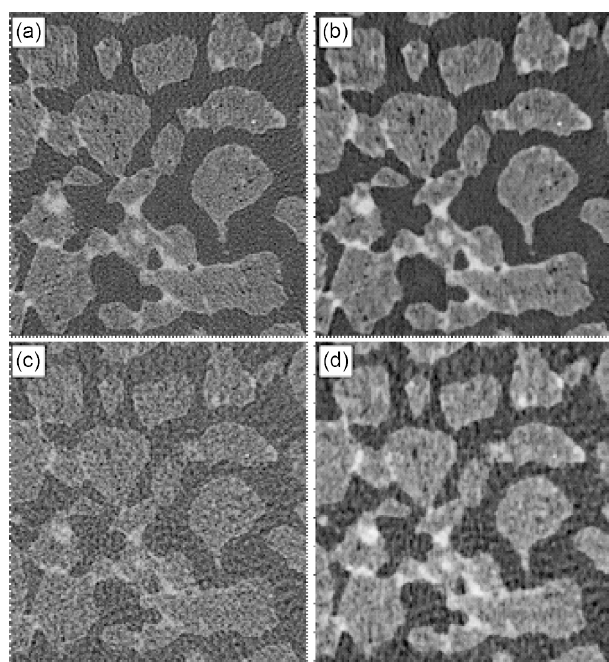
Figure 9. Two-dimensional reconstructed slices through a gravel sample using filtered back projection (a, c) and an iterative opti- misation method with the total variation regularisation incorporated as prior information (b, d) . Reconstructions are obtained using 180 projections (a, b) and 90 projections (c, d) . The cropped area shown is approximately 3.5mm × 3.5mm. Note the increased definition of both the inter- and intra-grain porosity that can be achieved for a given number of projections. Data are from sample LD_3, first frame, scan 1. The optimised iterative methods took approximately 45min ( b , 180 projections) and 15min ( d , 90 projections) per 3-D frame, making them a viable element of the post-processing work- flow for key datasets.